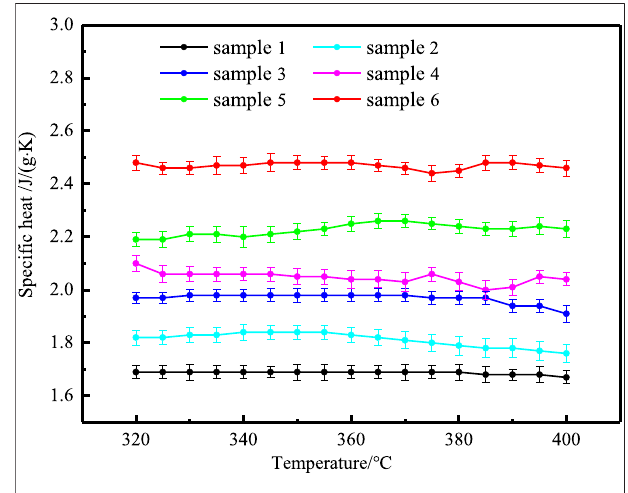
FIGURE 8 | Speci fi c heat after phase change of different samples vary